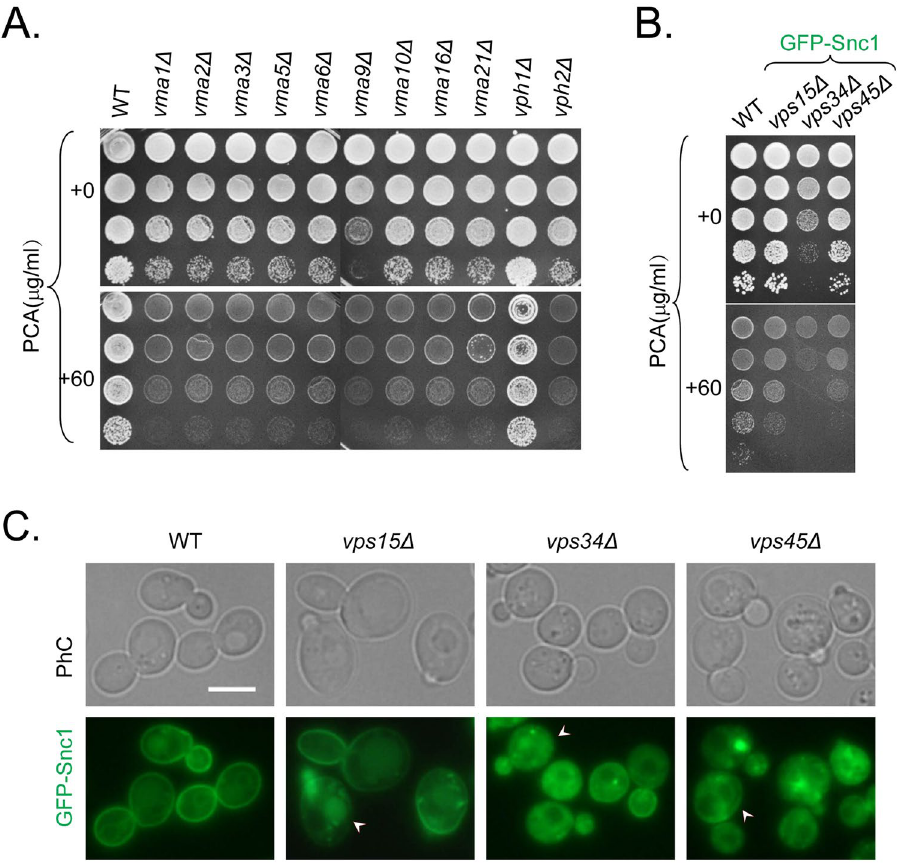
Figure 4. Mutants defective in vacuolar ATPase and protein sorting show increased sensitivity to PCA. ( A ) Overnight YPD-cultured wild-type and vacuolar ATPase-mutant cells were spotted onto YPD plates containing 0 or 60 μ g/ml PCA and incubated for 2 days at 26 °C. ( B ) Overnight YPD-cultured wild-type and protein sorting-mutant cells tagged with GFP-Snc1 on the chromosome were spotted onto YPD plates containing 0 or 60 μ g/ml PCA and incubated for 2 days at 26 °C. ( C ) Wild-type and protein sorting-mutant cells tagged with GFP-Snc1 on the chromosome were grown to mid-log phase in YPD for 5 h to examine GFP-Snc1 localization. White arrowheads indicate cells in which the polar distribution of GFP-Snc1 was lost. The bar represents 5 μ